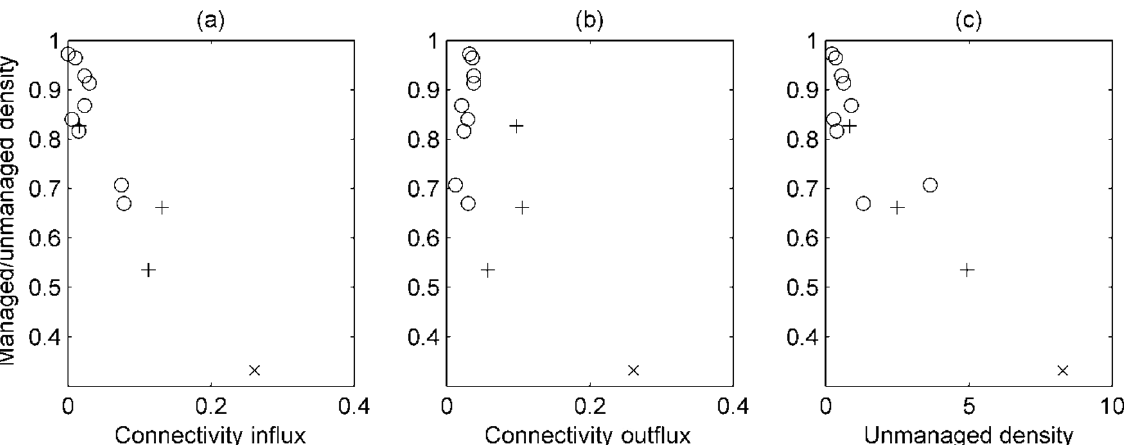
Fig. 7. Impact of applying management protocol to model sites, measured by proportional mean lice abundance over all model sites over the whole production cycle, relative to the unmanaged case. Again, parameters applied were a constant external in- fection of 0.01 lice fish −1 d −1 and reproduction of 5 lice adult female −1 d −1 . Impact of managing particular sites is plotted versus (a) connectivity influx, (b) connectivity outflux, and (c) unmanaged density of those sites. Individual sites are indicated by ’ O ’, groups of 3 sites by ‘+’, and all sites managed together by